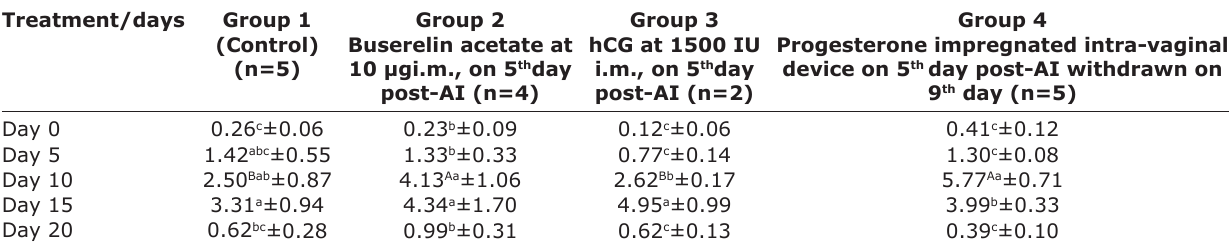
Table-2: Study of mean plasma progesterone values of non-pregnant animals of different groups on different days of the estrous cycle. Treatment/days